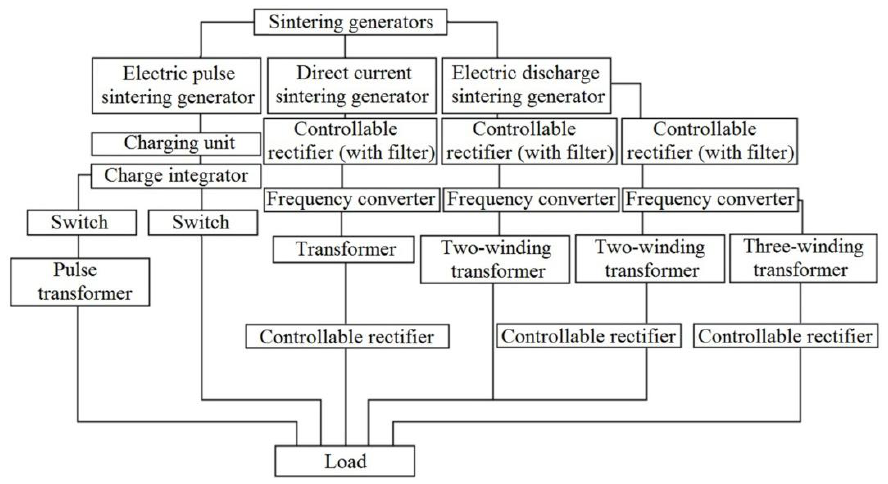
Figure 27. Classification of generator circuits used in sintering facilities.